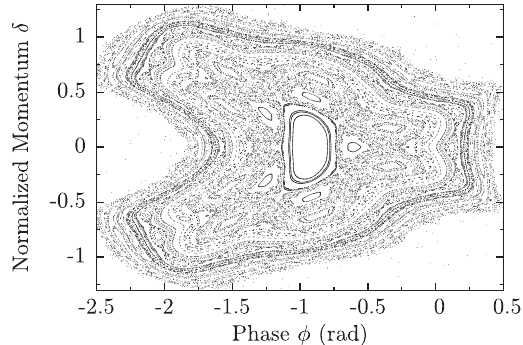
FIG. 12. Nondiffusive Poincaré surface of section depicting the longitudinal phase-space structure on the verge of particle loss ¼ 104 ° and Δ ϕ ¼ 30 °. Note that instead of the well- where a m o behaved tori, the structure is bounded by layers of overlapping resonances that will result in particle